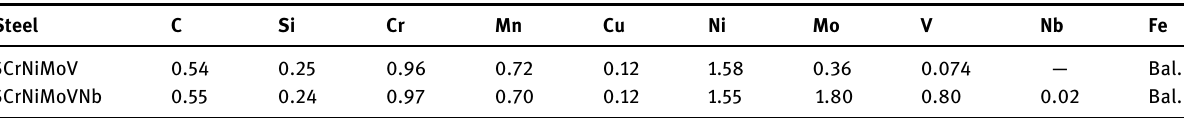
Table 1: Chemical composition of 5CrNiMoV and 5CrNiMoVNb steel Steel